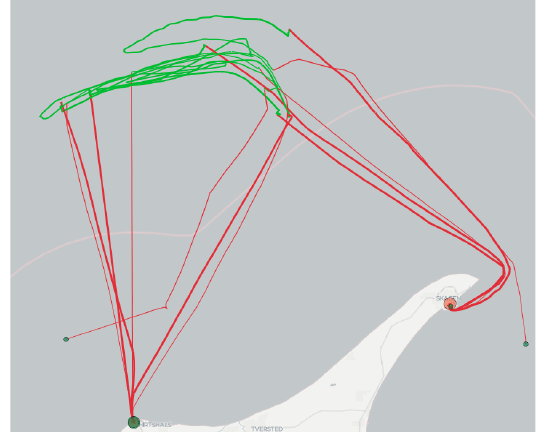
Figure 17 . Examples of fishing vessel tracks identified in fishing (green) and moving (red)